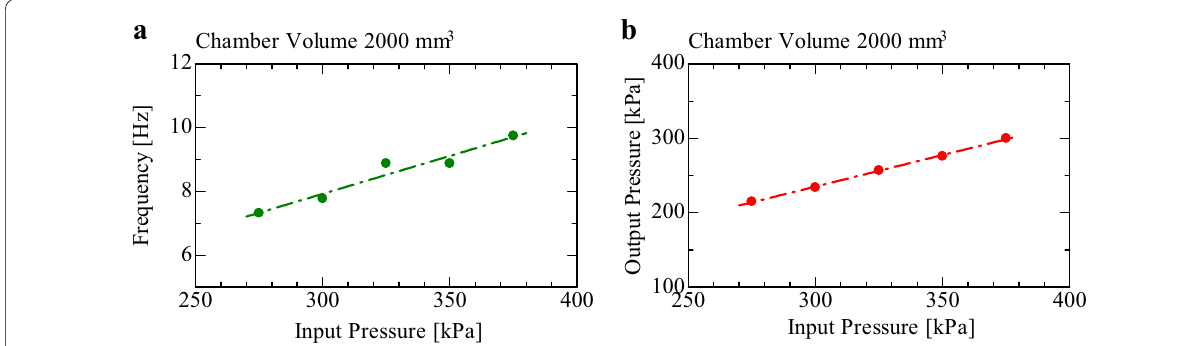
Fig. 11 Frequencies and output pressures affected by the input pressure. a Relationship between the input pressure and the frequency. b Relationship between the input pressure and the output pressure